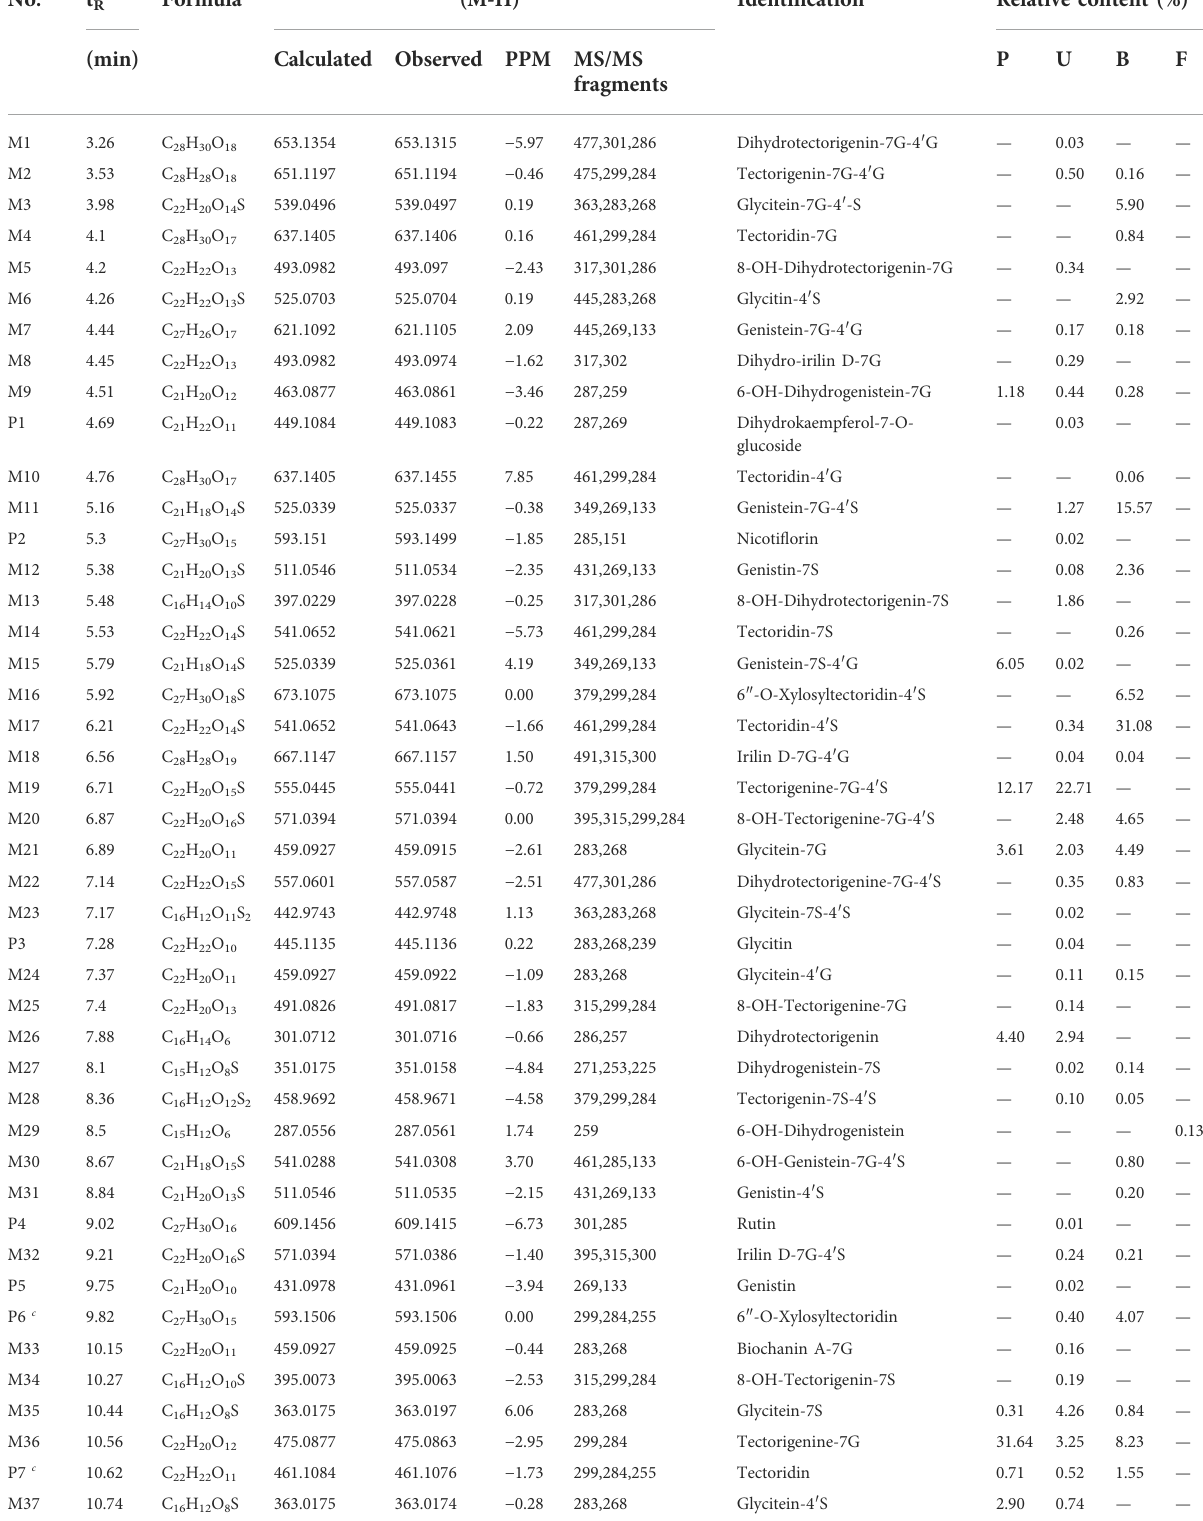
TABLE 1 Characterization of the metabolites in rat after oral administration of P. montana var. thomsonii (Benth.) M. R. Almeida extract by UHPLC- QTOF MS. No. t